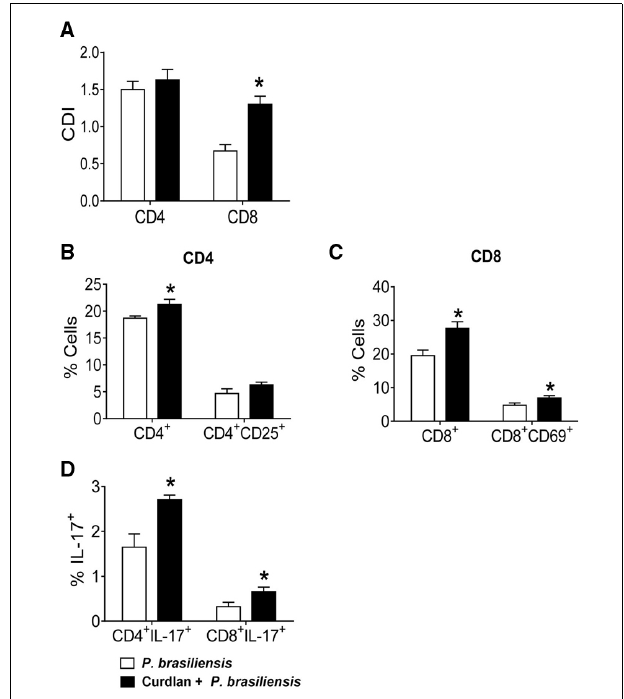
FIGURE 1 | Influence of curdlan, a Dectin-1 agonist, in T cell proliferation, activation and development of IL-17 producing T cells. BMDCs of WT C57BL/6 mice were cultured in the presence of GM-CSF and IL-4 for 5 days. The DCs were then treated or not with curdlan (100 m g/ml) for 30 min and infected with viable P. brasiliensis yeasts for 2 h. Splenic lymphocytes from uninfected C57BL/6 mice were labeled with CFSE (5 mM) and co-cultivated with curdlan treated and untreated infected DCs. After 5 days, the cells were adjusted to 1 (cid:2) 10 6 , labeled with specific anti-CD4, CD8, CD25, and CD69 antibodies and analyzed by flow cytometry. (A) Proliferative response of CD4 + and CD8 + T cells. (B,C) The lymphocyte population was gated by FSC/SSC analysis and gated cells were analyzed for CD4 + CD25 + (B) and CD8 + CD69 + (C) expression. Some cells were re-stimulated with PMA/ionomycin for 6 h and subjected to intracellular staining for IL-17 (D) . The results are expressed as frequency of positive cells. Data